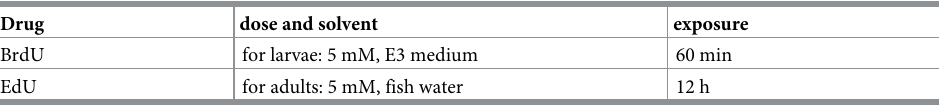
Table 5. Summary of drug